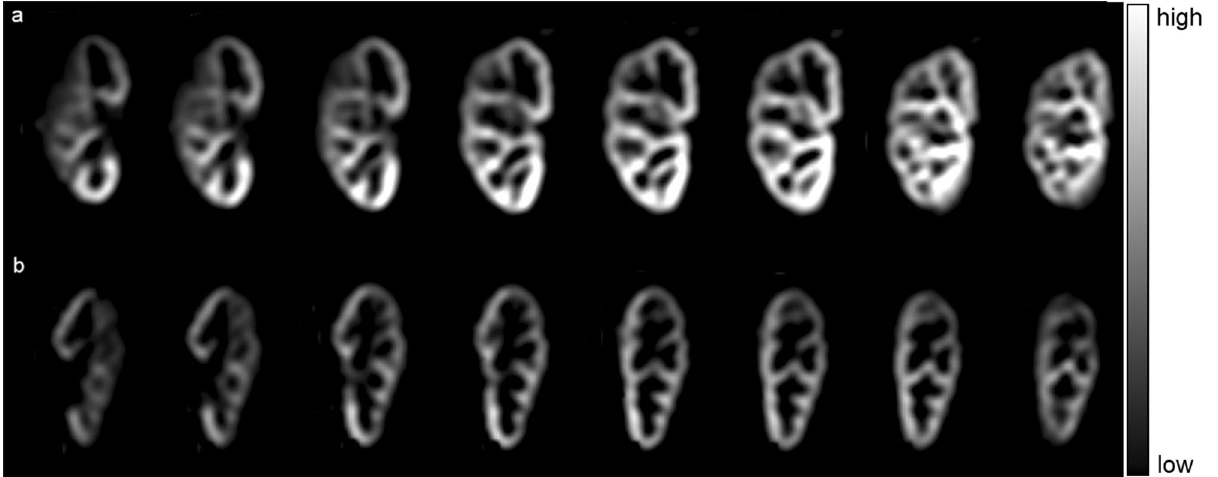
Figure 1. Multi-slice perfusion weighted images (PWI) in two representative patients with: ( a ) good allograft function (GFR ≥ 60 ml/min/100 g) and ( b ) impaired allograft function (GFR < 60 ml/min/100 g).